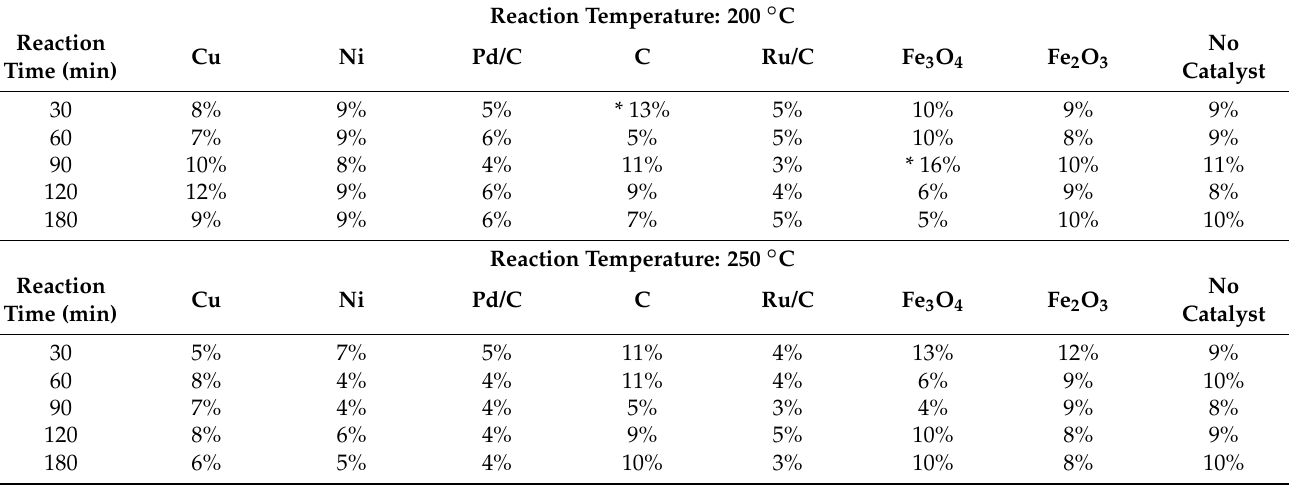
Table 6. Yields of lactic acid obtained after the hydrothermal reaction of NH 4 [H 2 NCO 2 ] with glucose in the presence of catalysts. The higher yields obtained after the hydrothermal reactions are marked with an asterisk